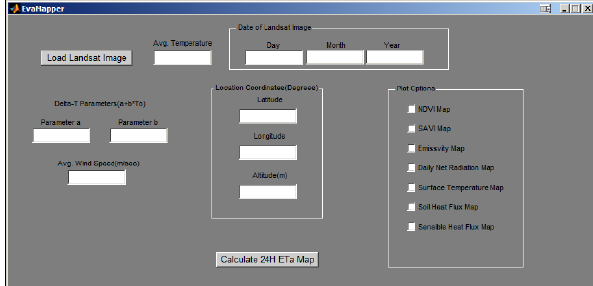
Figure 1. Graphic User Interface (GUI) of EvaMapper Toolbox